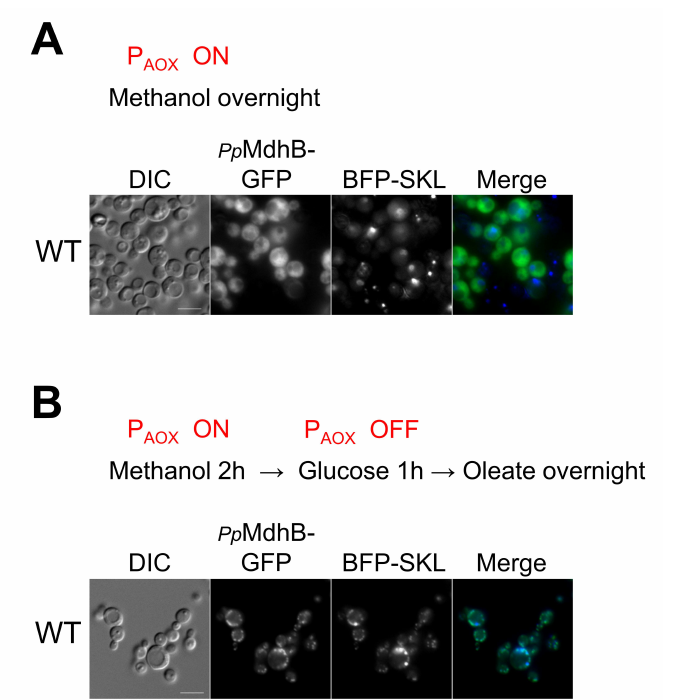
Figure 6. MdhB-GFP pulse-chase uncovers its localization to a small peroxisomal fraction. Fluo- rescence microscopy of Pp MdhB-GFP expressed from P AOX . ( A ) Strains were grown overnight in methanol. ( B ) Strains were grown for 2 h in methanol to express Pp MdhB-GFP (P AOX ON), trans- ferred to glucose for 1 h to repress the AOX promoter (P AOX OFF), and grown overnight in oleate to induce peroxisome proliferation. Colocalization studies with the peroxisome were observed with BFP-SKL as peroxisomal markers, respectively. Bars: 5 µ